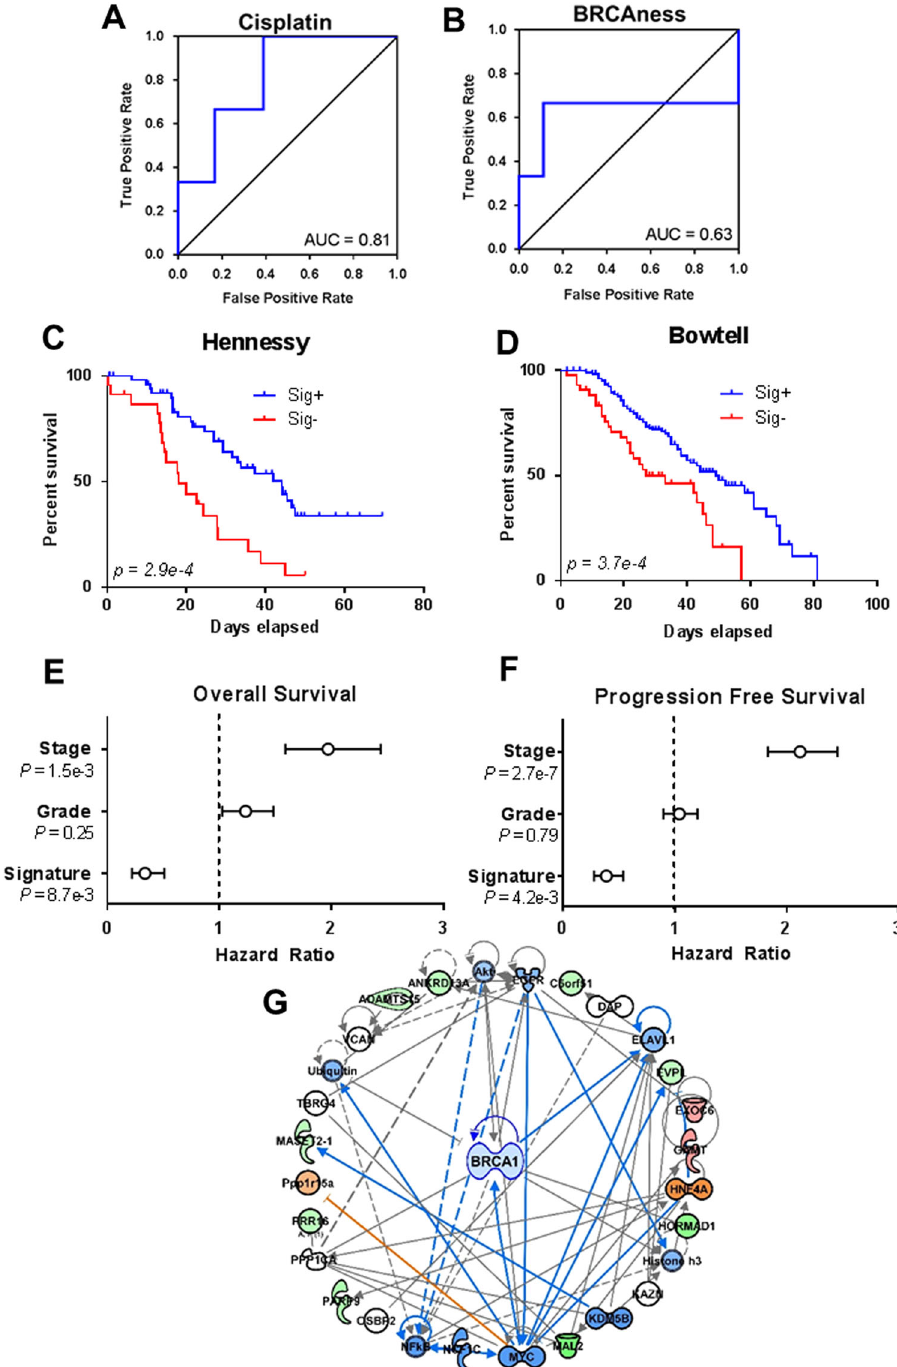
Fig. 2 The cisplatin sensitivity signature that was generated from IRAPS predicts cisplatin-treated ovarian cancer patient survival independent of cancer stage and grade. a ROC curve based on the cisplatin sensitivity score using the cisplatin testing set that consisted of triple-negative breast cancer and ovarian cancer cell lines. b ROC curve for the same cells as in 2a, but based on the BRCAness sensitivity signature score. c , d Patient survival analyses in two independent cohorts of ovarian cancer patients that were treated with cisplatin were separated based on the cisplatin sensitivity score. Log-rank p -value is displayed that shows statistical signi fi cance. e , f High cisplatin sensitivity scores predict improved overall survival ( e ) and progression free survival ( f ) independent of stage and grade using a Cox proportional hazards model. g Ingenuity pathway analysis of the cisplatin sensitivity signature indicates a predicted down-regulation of AG014699 (rucaparib) shown in Table S4. To generate an signature generated by IRAPS could improve patient selection for independent test set, we screened a panel of breast and ovarian PARP inhibitors. For this analysis, we again optimized the cancer cell lines for sensitivity to the PARP inhibitor BMN-673 algorithm for both ovarian and breast cancer cell lines by using (Fig. 3a, b). Testing cell lines were excluded from the IRAPS sensitivity data for the PARP inhibitors AZD2281 (olaparib) and